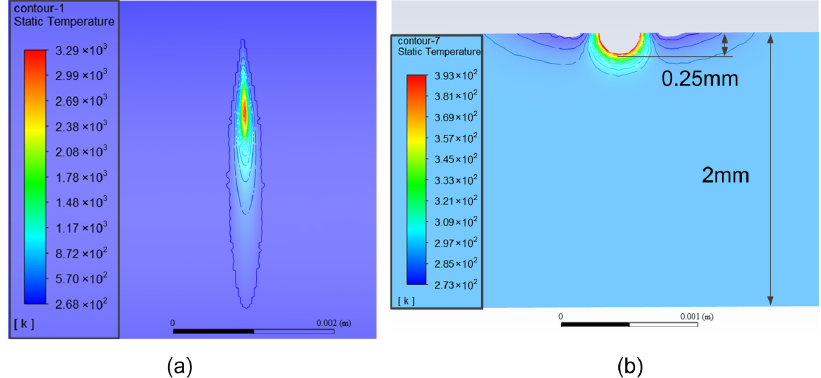
Figure 7. The contours of the temperature distribution: ( a ) temperature distribution near laser spot; ( b ) temperature profile in tube wall.